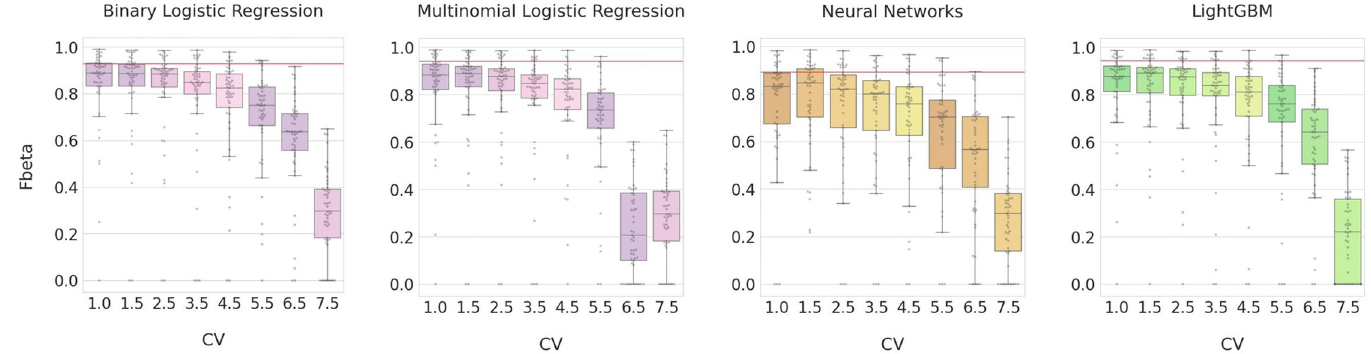
Fig 6. Model performance on the kidney dataset. Four models (Binary Logistic Regression, Multinomial Logistic Regression, Neural Networks, and LightGBM) were built using the optimal hyperparameters trained from the MTG dataset. Eight CV thresholds (1.0, 1.5, 2.5, 3.5, 4.5, 5.5, 6.5, and 7.5) were applied for feature selection. The red horizontal line indicates the median F-beta value for the best CV threshold for a given method from the MTG dataset.